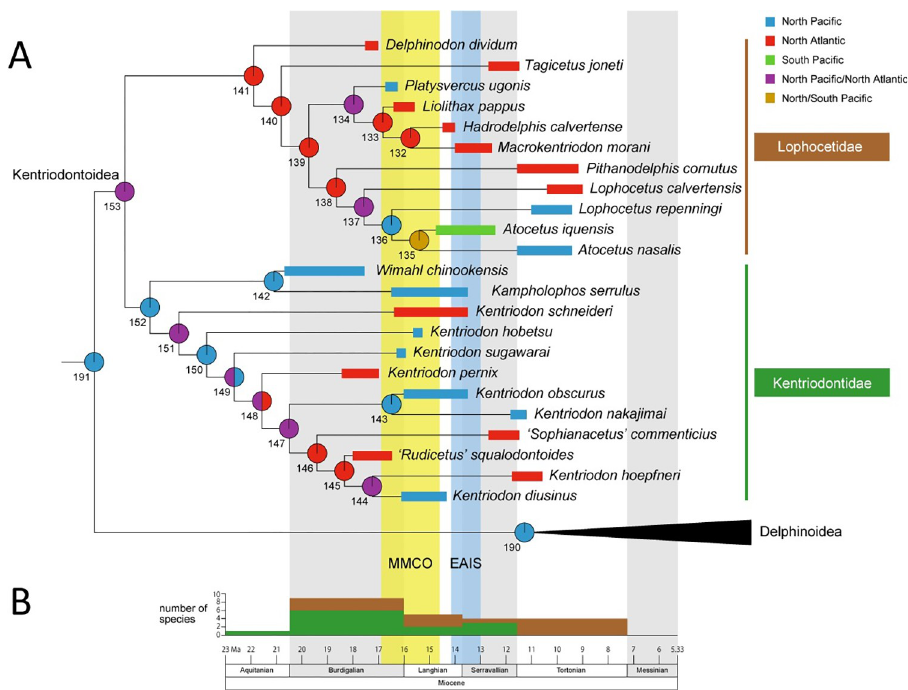
Fig 8. Paleobiogeography and diversification of kentriodontoids. (A) Summary of the topology, ancestral range reconstructions and paleobiogeography of the kentriodontoids. The topology of the Kentriodontoidea is based on our phylogenetic analysis (Fig 7). Stratigraphic ranges of each species are based on previous studies (see Supplemental Data 1 Table S1 and Appendix S5 in S1 File). Pie charts at each node show the ancestral range reconstructions, numbers below in the pie chart indicate node number (Supplemental Data 1 Fig S4 in S1 File for complete results). (B) Number of species richness based on first occurrences of each kentriodontoid at each stage in the Miocene. Species of the Lophocetidae are brown in color and those of the Kentriodontidae are dark green in color. Abbreviations: MMCO, the Middle Miocene Climatic Optimum; EAIS, expansion of the East Antarctic Ice Sheet.